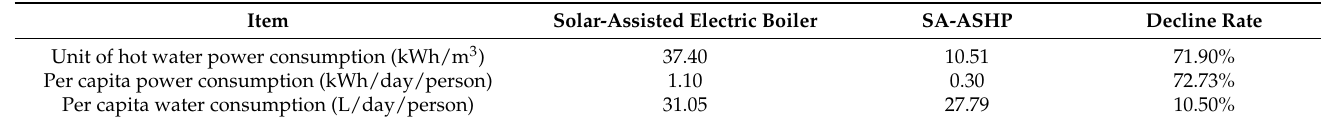
Table 2. Comparison of energy and water consumption indicators between the two solar water heating systems.